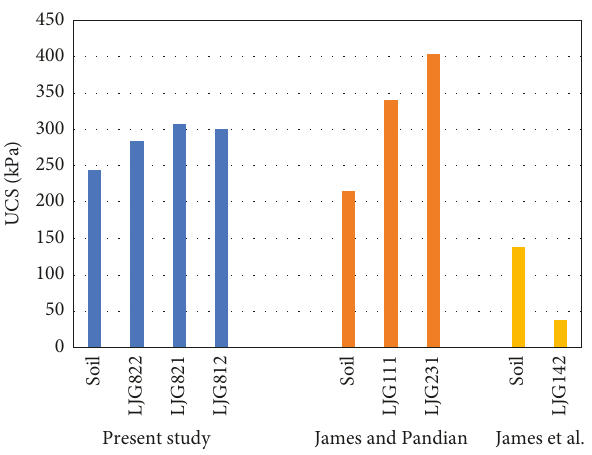
Figure 5: Comparison of present work with previous studies.